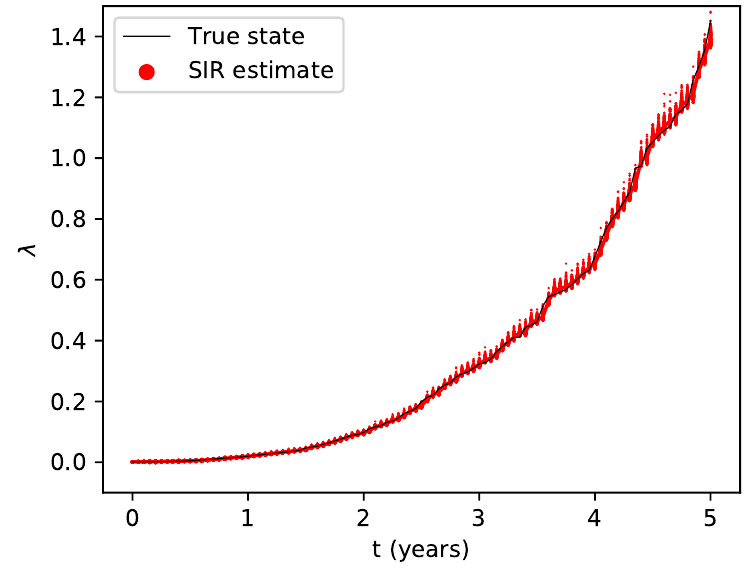
Figure 3. Degradation state online estimation—a priori distribution (dot size represents particle